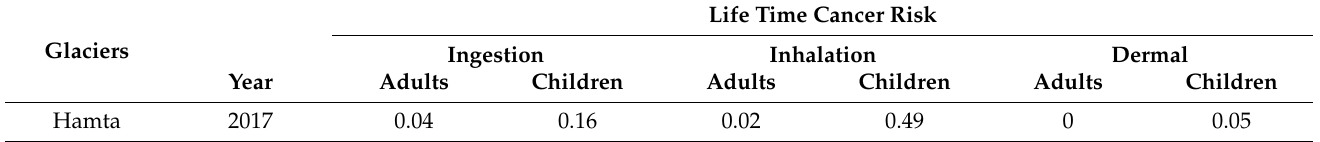
Table 8. Life time cancer risk assessment ( × 10 − 6